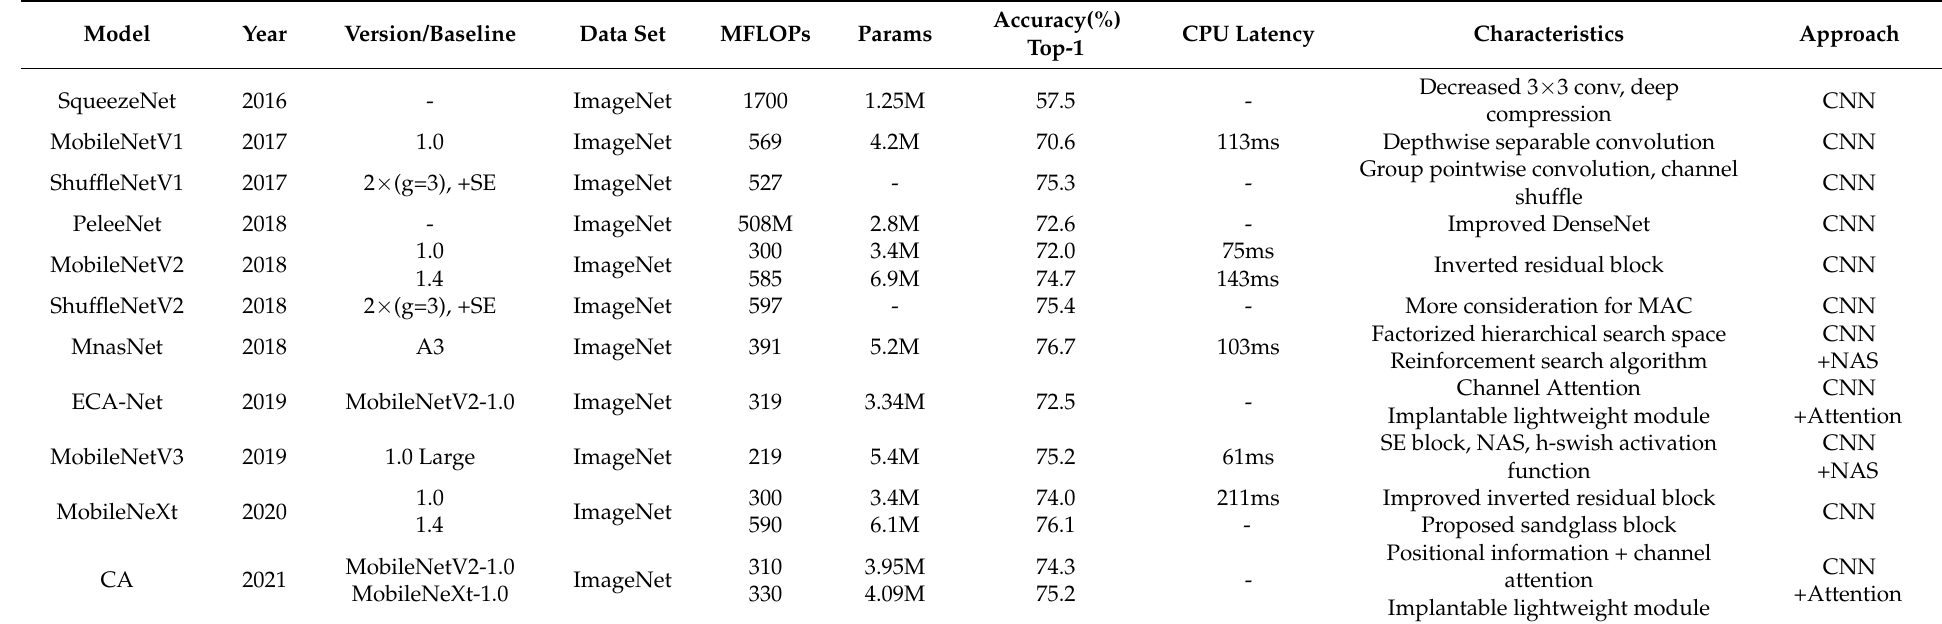
Table 4. Comparison of Various Image Classification Lightweight